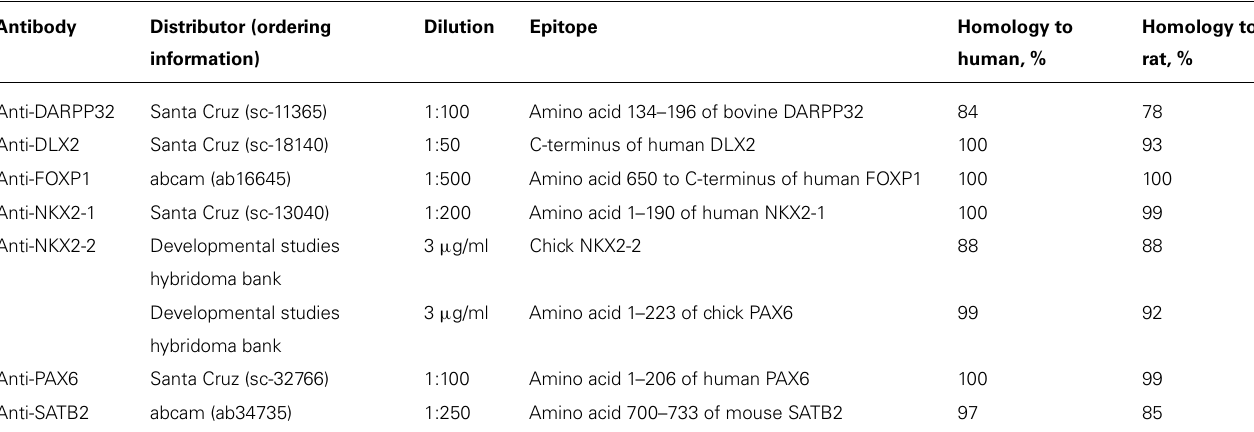
Table 1 |Antibodies validated to work on human and rat fetal tissue